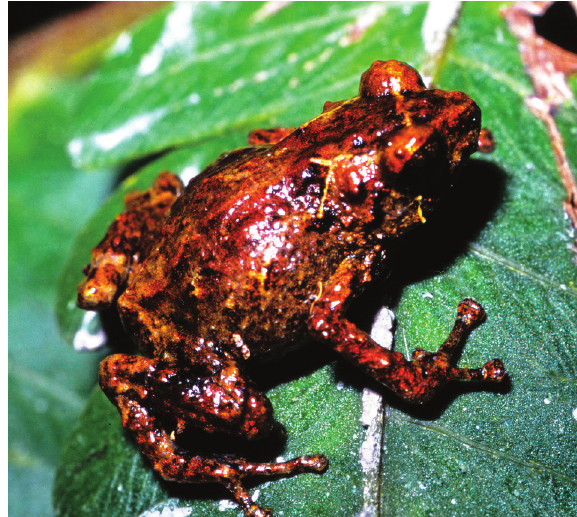
Figure 7. Paratype SAMA R70324 of Choerophryne